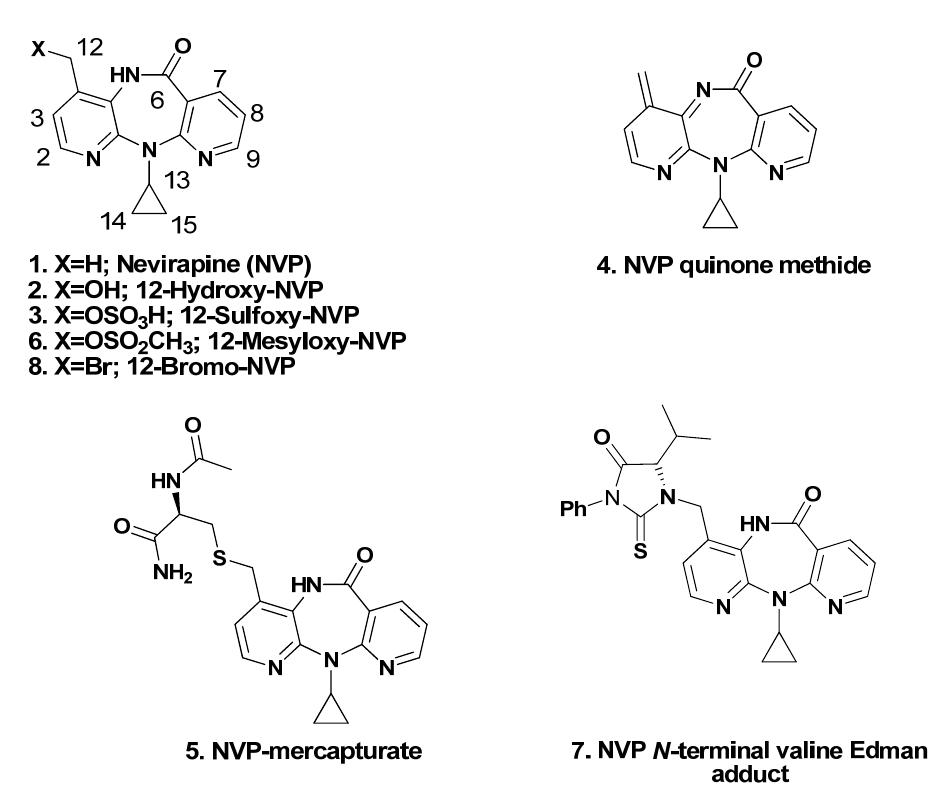
Figure 1. Structures of NVP ( 1 ), NVP metabolites 2 , 3 and other NVP derivatives 4 – 8 mentioned in the